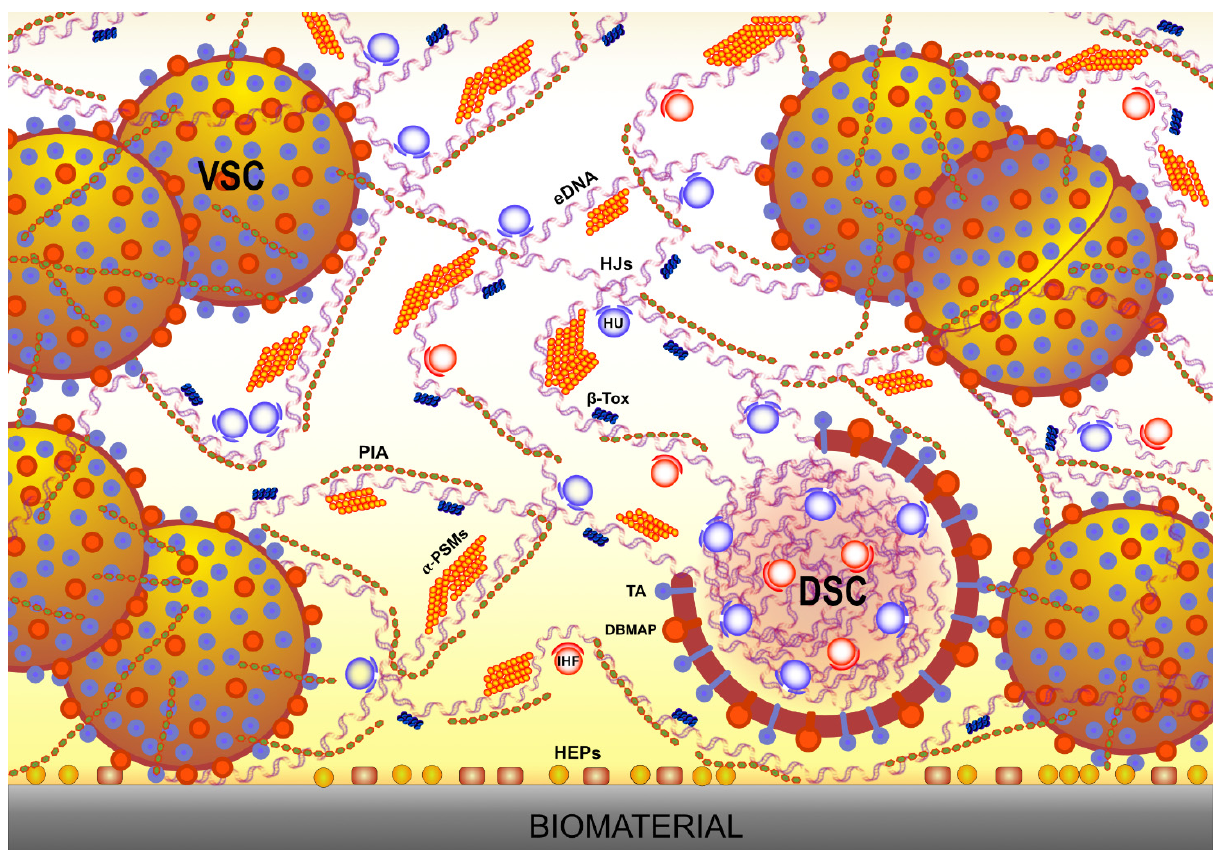
Figure 2. This scheme attempts to illustrate the various and complex molecular interactions taking place within the ma- trix of staphylococcal biofilms. Water-soluble molecules are retained by their mutual stabilizing interactions. The attention is focused on the variety of molecular species emerged to be involved and the real size ratio among different categories of molecules is not fully respected. During biofilm maturation, eDNA becomes progressively protected by the complexation with the other polymers and resistant to DNase digestion. Legend: VSC, viable staphylococcal cell; DSC, dead staphylococcal cell; HJs, eDNA Holliday junctions; PIA, polysaccharide intercellular adhesin; HU, histone-like nucleoid-associated protein HU; IHF, integration host factor; SaeP, S. aureus Saep lipoprotein; TA, (negatively charged) teichoic acids; β -Tox, S. aureus β -Toxin; α -PSMs, amyloidogenic α -Phenol-soluble modulins; DBMAP, DNA-binding membrane-associated proteins and membrane-anchored lipoproteins such as S. aureus SaeP and IsaB; HEPs, host extra- cellular-matrix proteins.